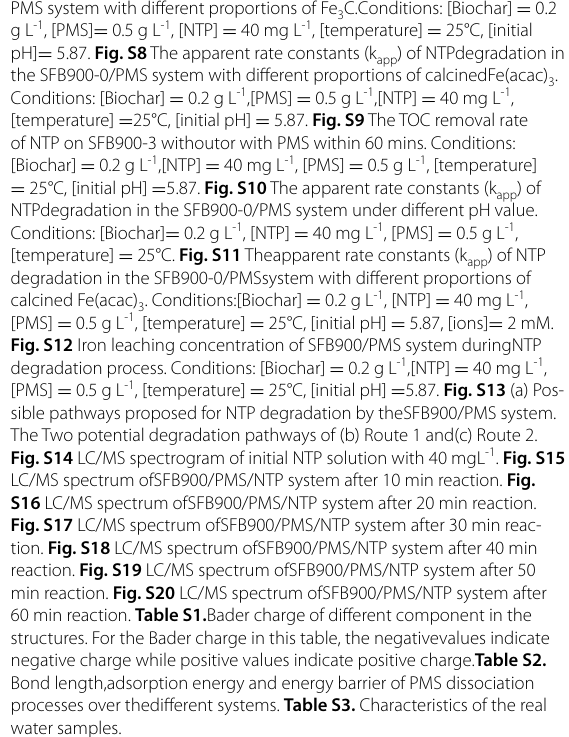
Fig. S17 LC/MS spectrum ofSFB900/PMS/NTP system after 30 min reac- tion. Fig. S18 LC/MS spectrum ofSFB900/PMS/NTP system after 40 min reaction. Fig. S19 LC/MS spectrum ofSFB900/PMS/NTP system after 50 min reaction. Fig. S20 LC/MS spectrum ofSFB900/PMS/NTP system after 60 min reaction. Table S1. Bader charge of different component in the structures. For the Bader charge in this table, the negativevalues indicate negative charge while positive values indicate positive charge. Table S2. Bond length,adsorption energy and energy barrier of PMS dissociation processes over thedifferent systems. Table S3. Characteristics of the real water